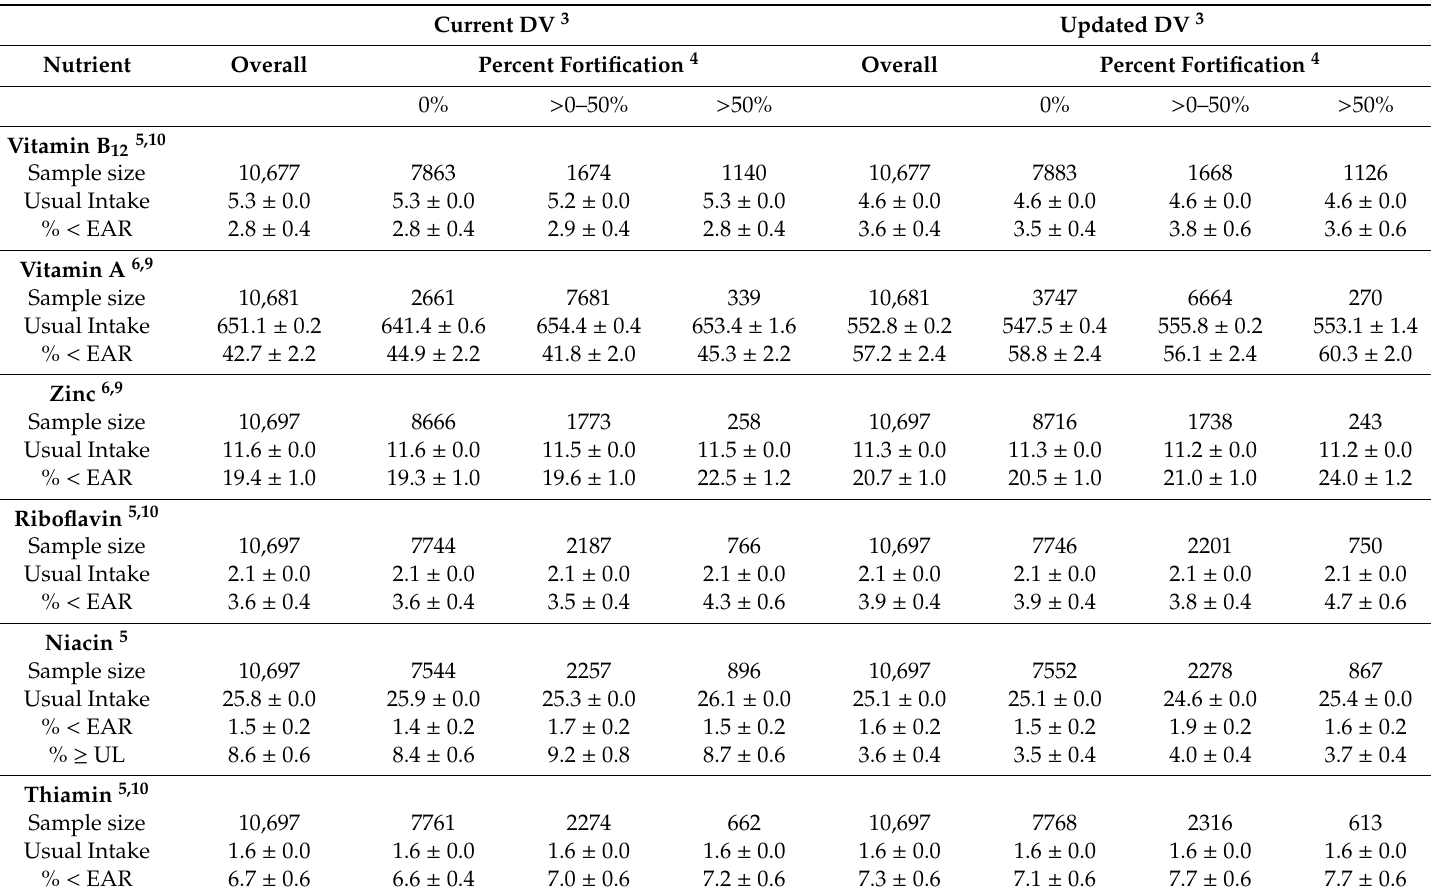
Table 5. Comparison of Current Daily Value (DV) and Updated DV nutrient intake models with overall and percent fortification subgroups for US adults ≥ 19 years of age, (Mean ± SEM) 1,2